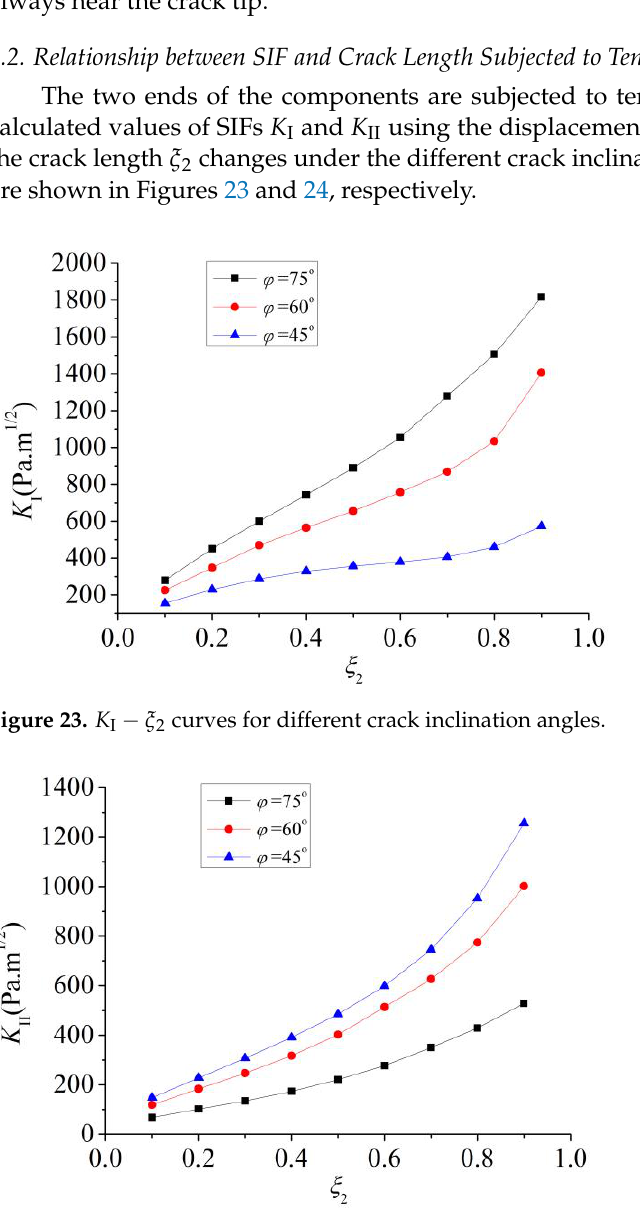
Figure 24. K II − ξ 2 curves for different crack inclination angles.